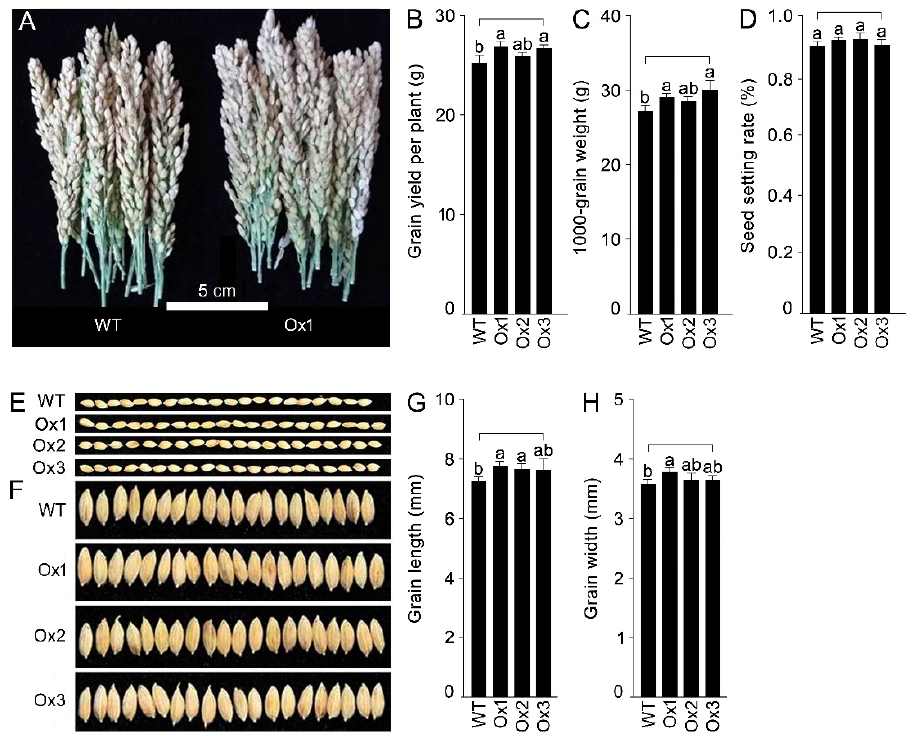
Figure 7. Overexpression of OsPHT1;4 accentuates yield performance of WYJ 7. WT and Ox1–Ox3 plants were grown in the field as described in the legend of Figure 6. Photographs of material from the WT and Ox1 plants show the phenotypes of panicle ( A ), grain length ( E ), and grain width ( F ). Data are presented for grain yield per plant ( B ), percent seed setting rate ( C ), 1000-grain weight ( D ), grain length ( G ), and grain width ( H ). Values are means ± SE ( n = 5). Different letters above the bars indicate significant differences ( p < 0.05, one-way ANOVA).